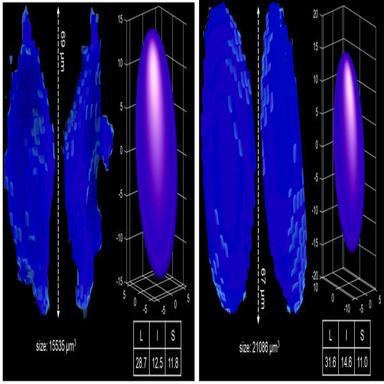
3D visualisations of single representative void and fitted ellipsoid for Victrex 3D (left) and L&V 3D (right); scale bar shows samples' printing direction (Zaxis); L, I, S, axis length expressed in µm.